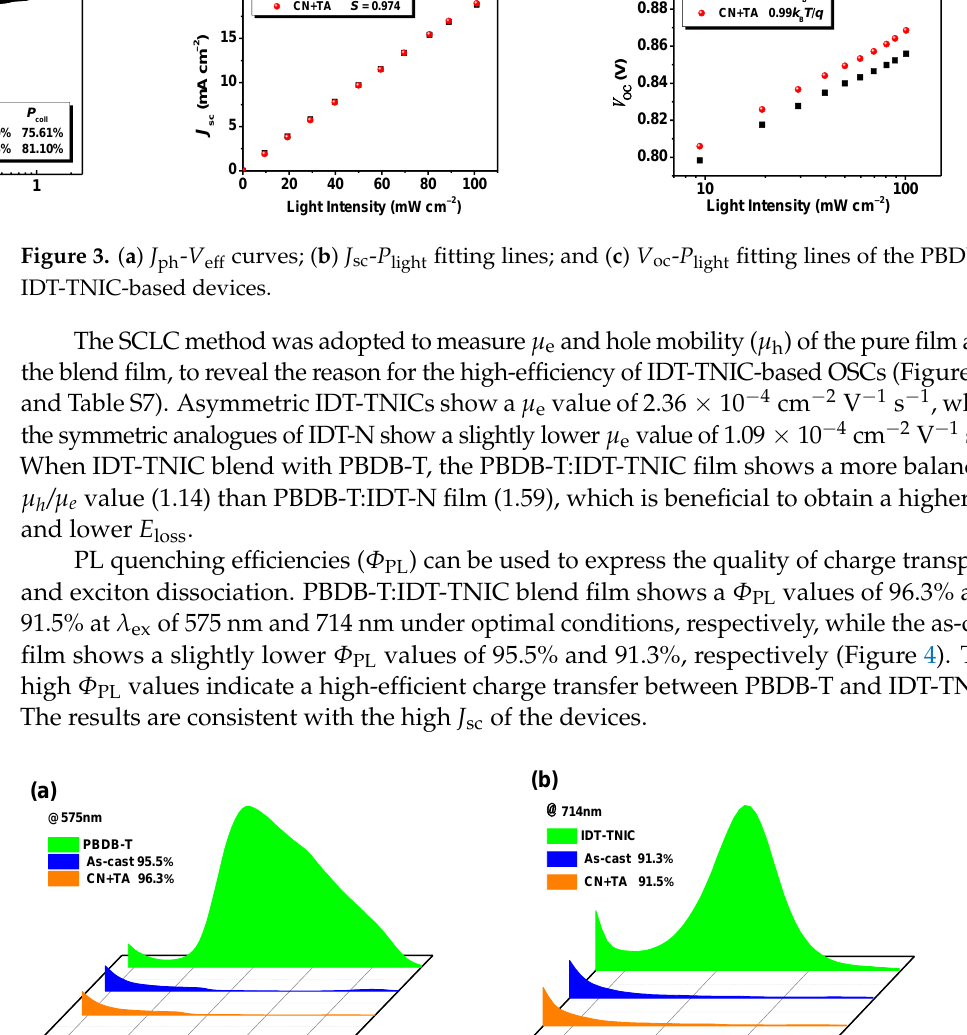
wavelengths of 575 nm and 714 nm.